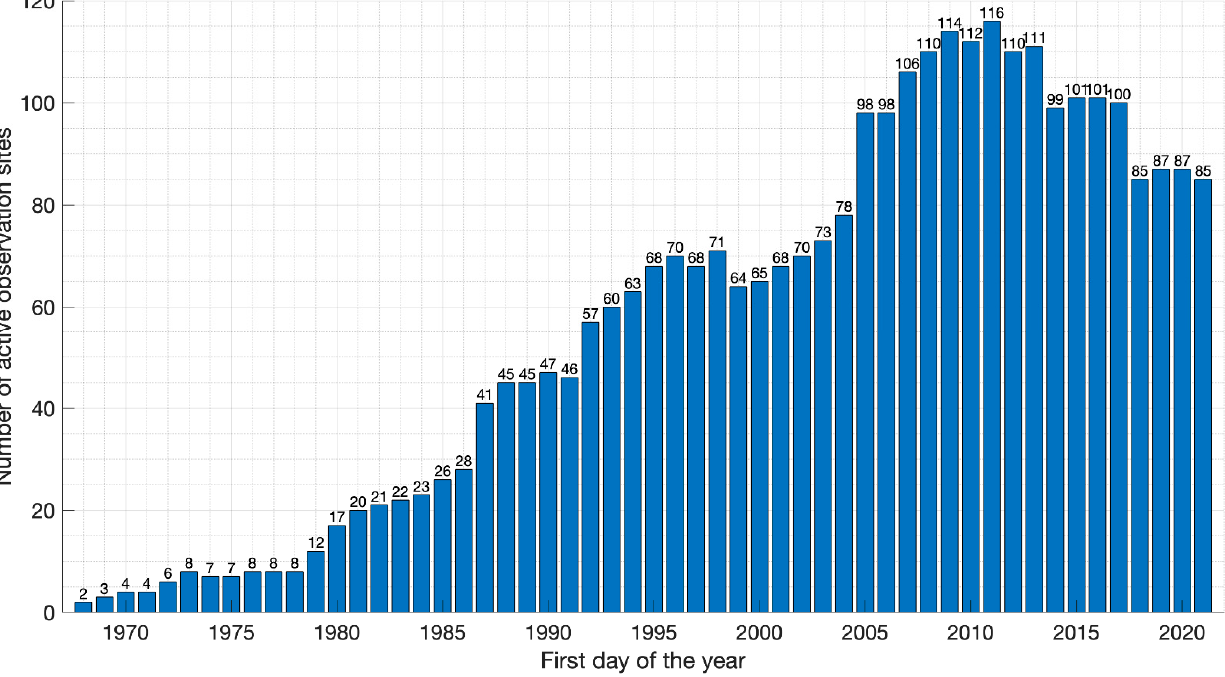
Figure A2. Comparison of satellite observations and TCCON stations (References detail are provided in the Table A4 in the Appendix A.) . The different studies are labelled based on references.